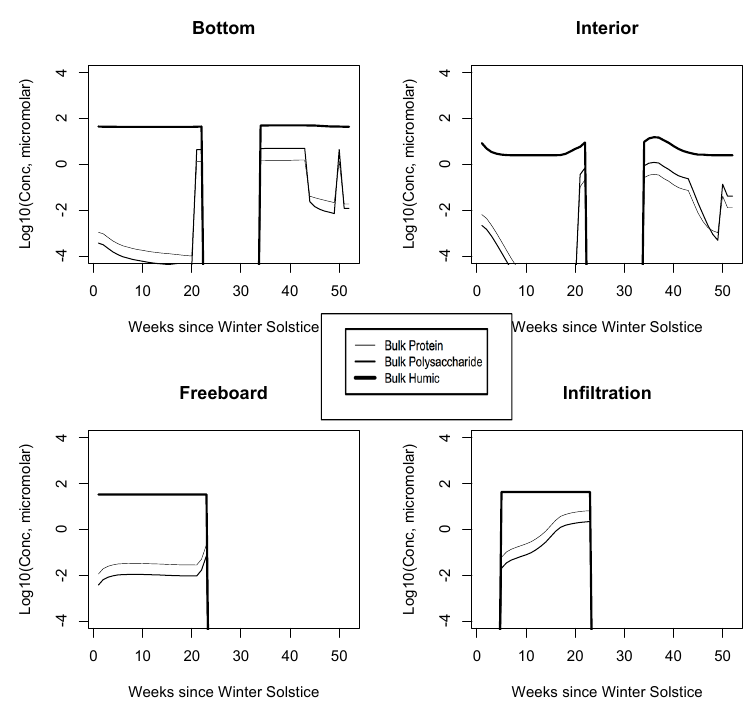
Figure 8. Chukchi Sea, caption as in Figure 7.